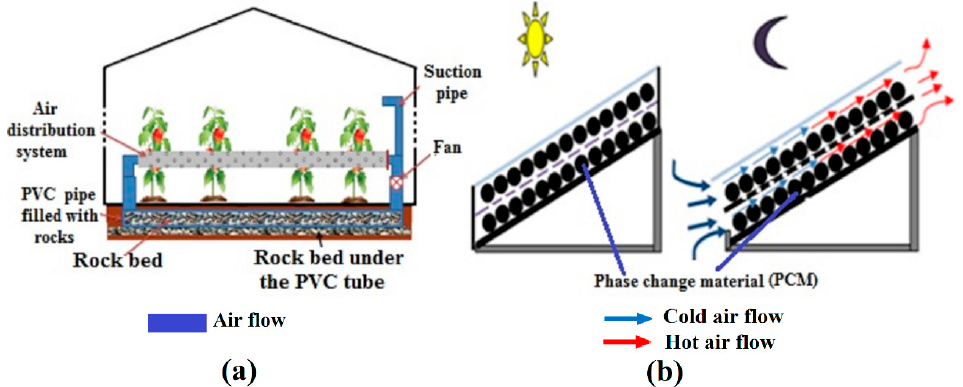
Figure 11. Thermal-storage-based systems used in greenhouses: ( a ) rock bed storage [152]; ( b ) PCM storage.